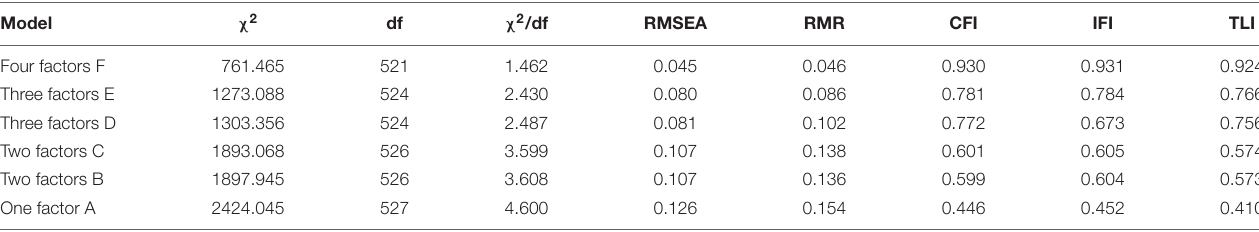
TABLE 2 | Confirmatory factor analysis.